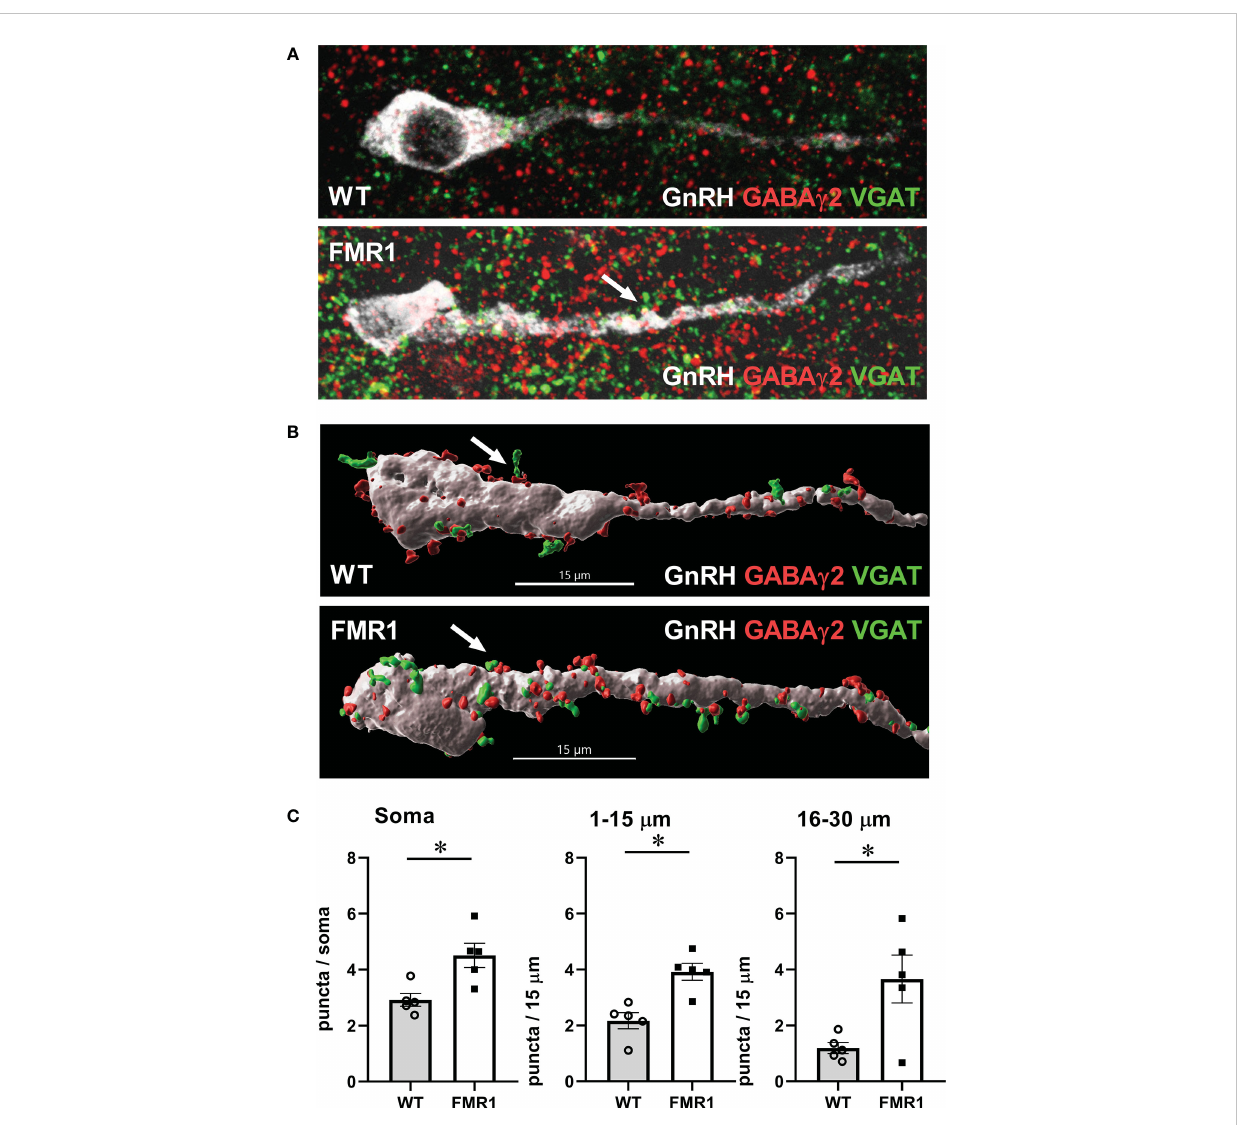
FIGURE 10 GnRH neurons of Fmr1 KO females have more synaptic GABA A receptors. (A) Representative images of triple stain for presynaptic VGAT (green), GABA g 2 receptor (red) and GnRH (white); (B) 3-D GnRH neuron models using Imaris software. VGAT (green) appositions to GABA g 2 receptor subunits (red) in GnRH neurons (white) were counted in 15-20 neurons per mouse, fi ve mice from each group. (C) Quanti fi cation from different regions of the neuron, as above, is presented in panels, and signi fi cance indicated with